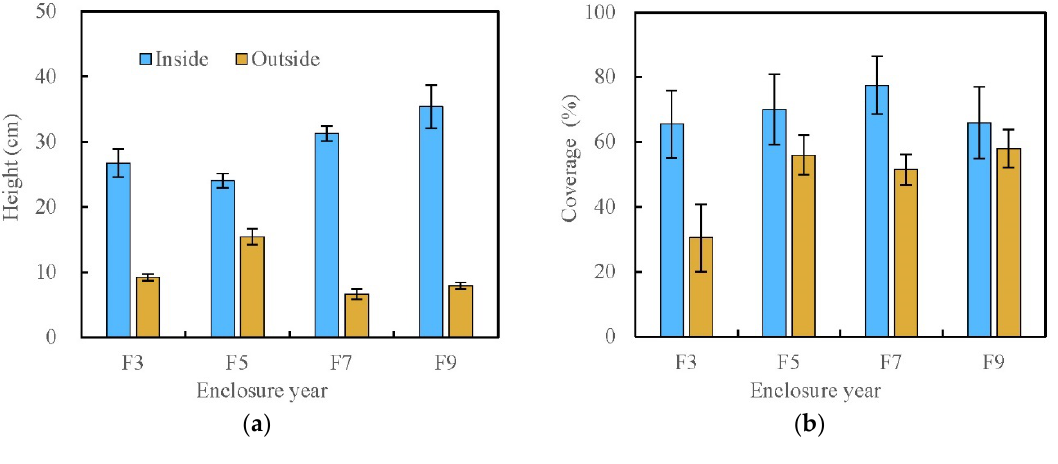
Table 1. The importance values of major plant species inside and outside the enclosure, %.